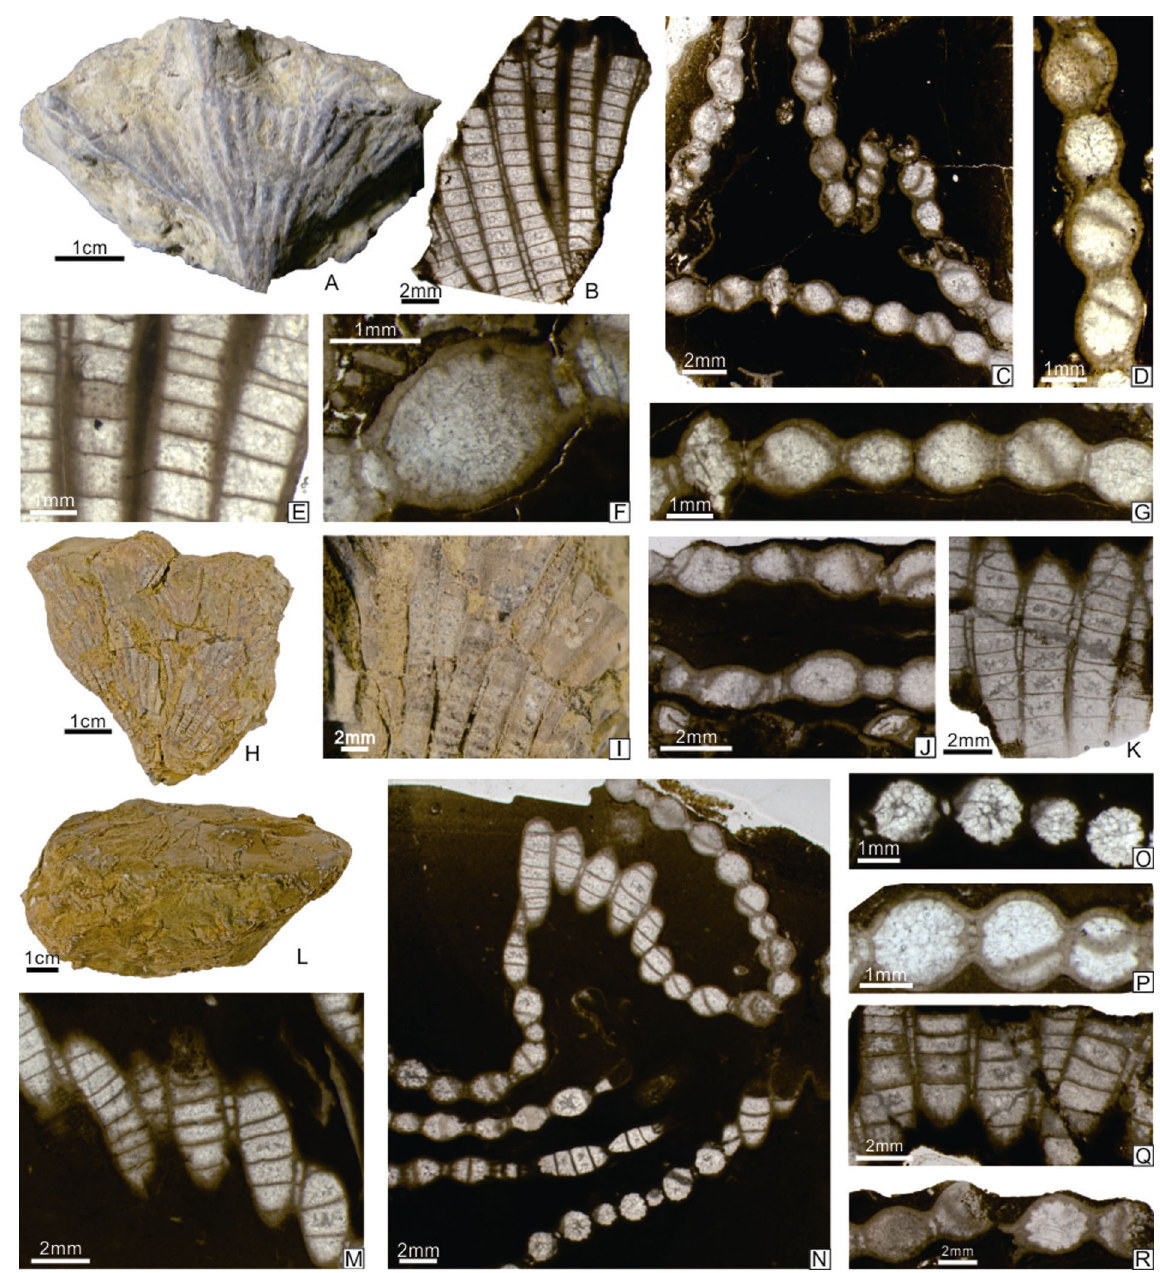
Fig. 2. A (cid:150) R , Halysites gaojiangensis sp. nov. from the Wulipo Bed at Gaojiang, Meitan, Southwest China. A(cid:150)G, NIGP160711, holotype: A, exterior lateral view of corallum; B, E, transverse section and its local enlargement; C, D, F, G, longitudinal section and its three local enlargements; H(cid:150)K, NIGP160712, paratype: H, I, exterior lateral view of corallum and its local enlargement; J, K, transverse and longitudinal sections. L(cid:150)P, NIGP160713, paratype: L, exterior lateral view of corallum; M, longitudinal section; N, O, P, transverse section and its two local enlargements. Q, R, NIGP160714, paratype: transverse and longitudinal